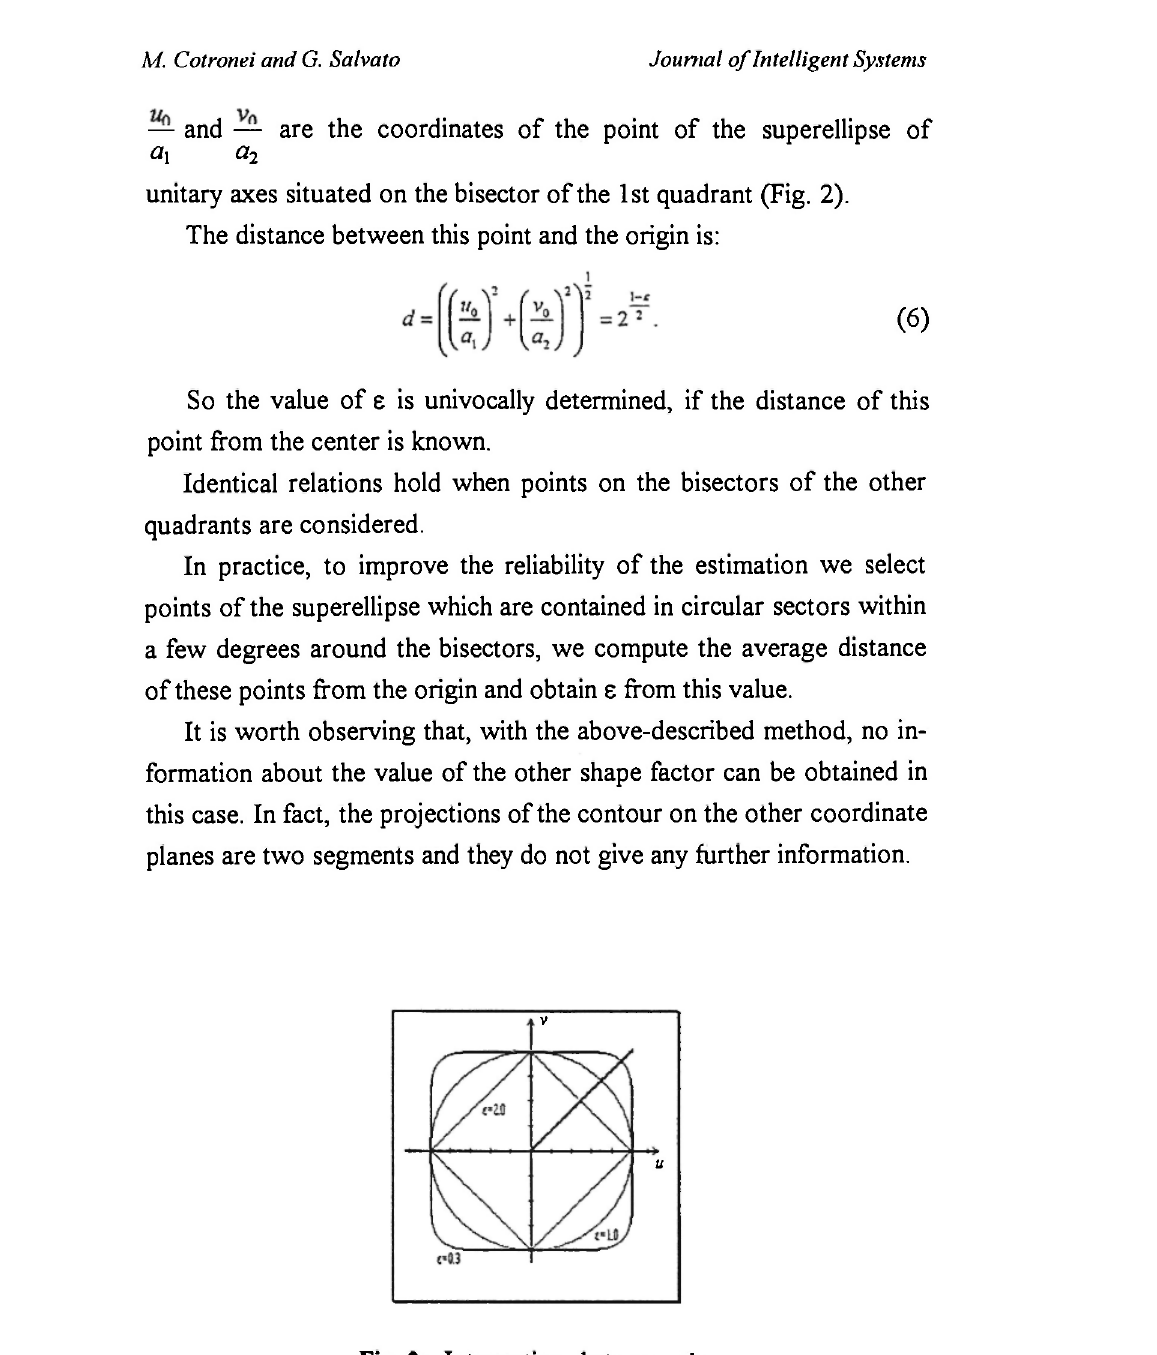
Fig. 2: Intersection between the bisector and the super- ellipses as a function of the shape